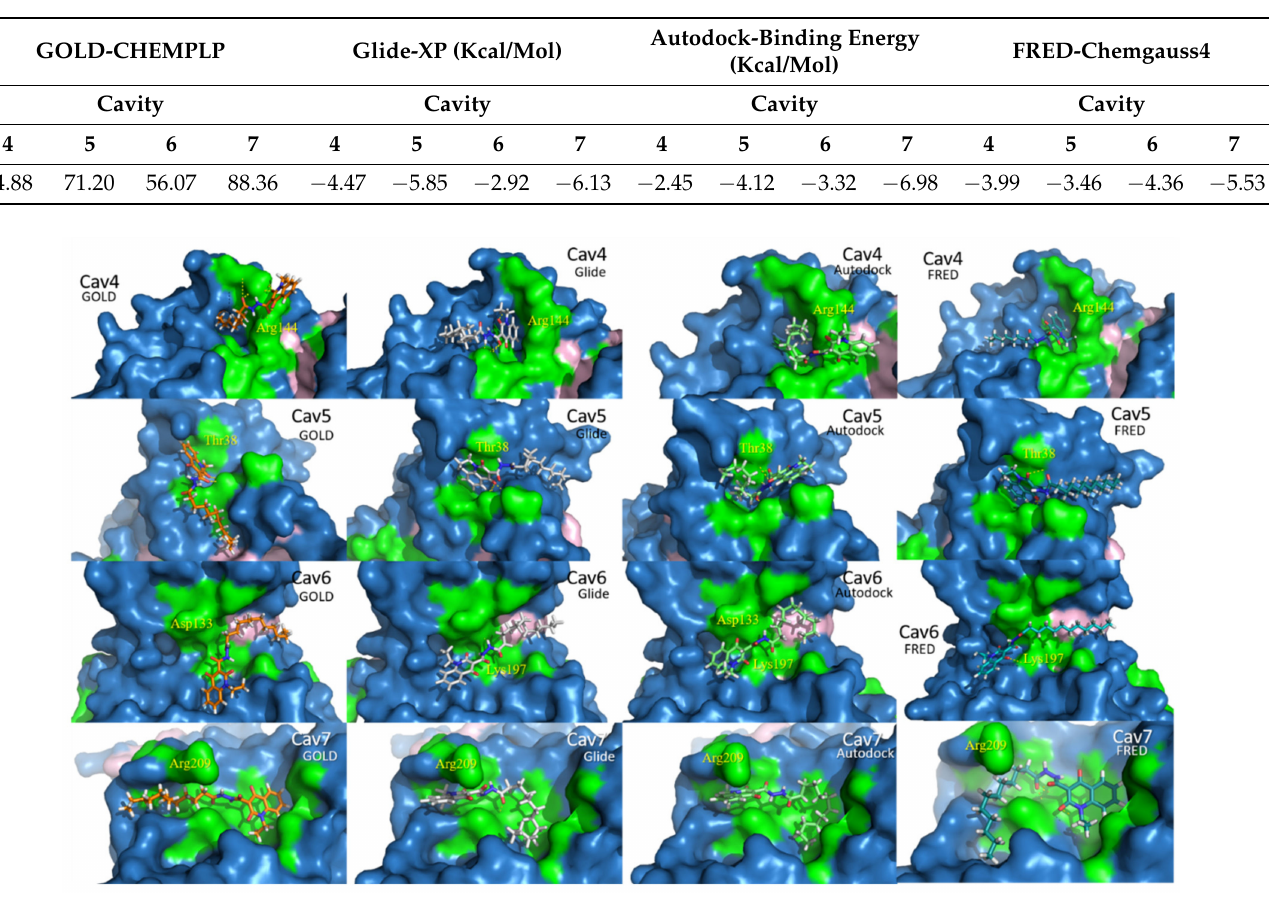
Figure 4. Representation of the docking poses obtained for compound 1 within each allosteric cavity (4, 5, 6, and 7) of protein GSK-3 β (1PYX.pdb) using GOLD, Glide, Autodock, and FRED software. Image prepared in Pymol